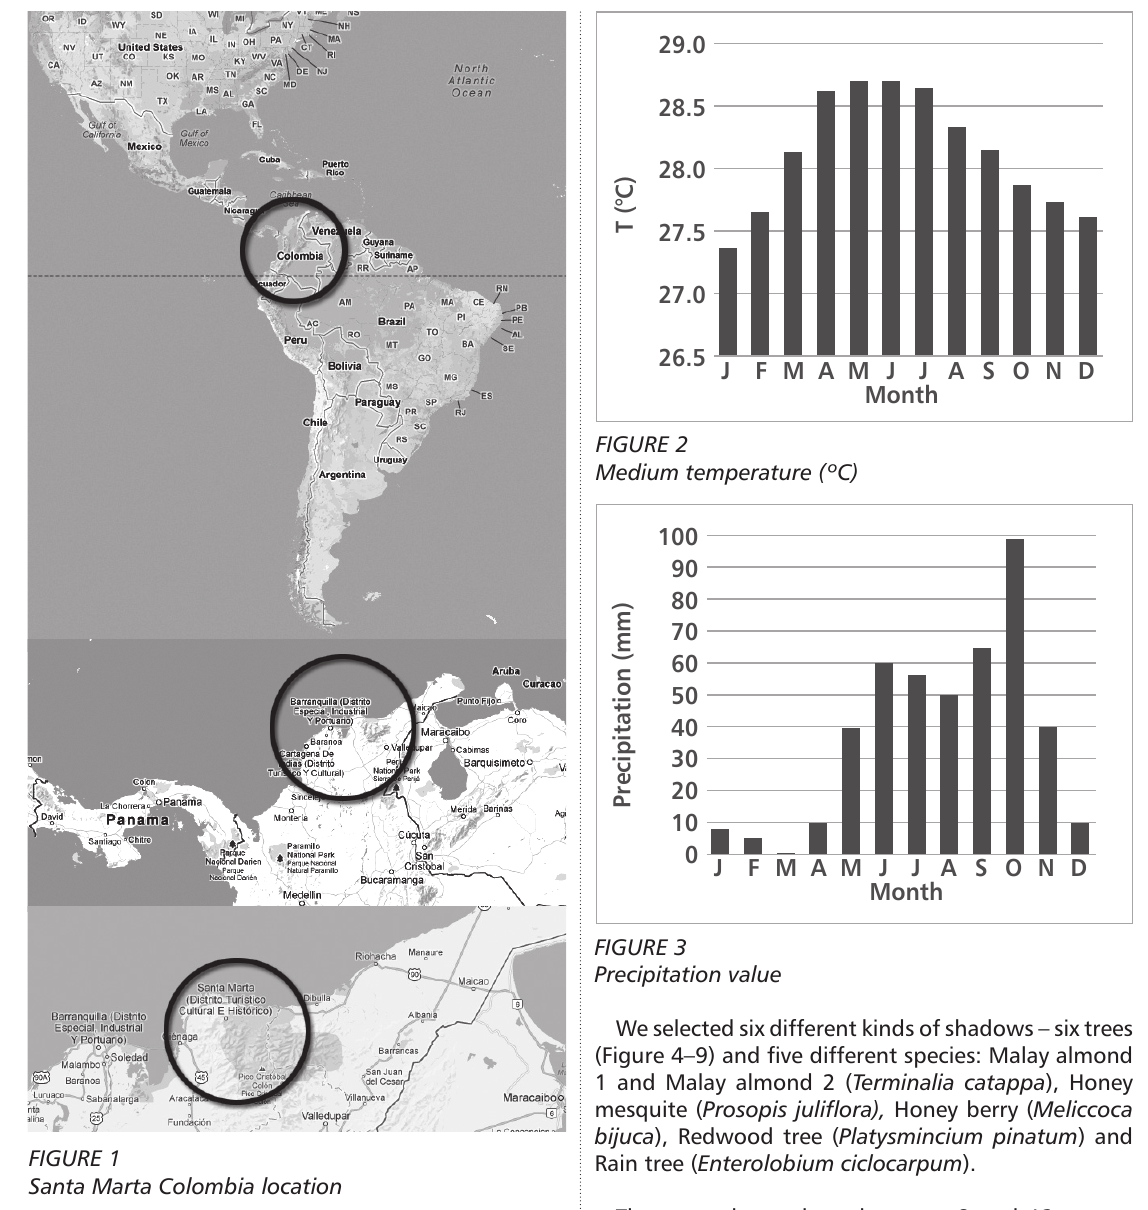
FIGURE 1 FIGURE 1 Phases of photogrammetric development, as a result Santa Marta Colombia location of technological innovations (source [36]) TABLE 1 Dendrometric information of selected trees